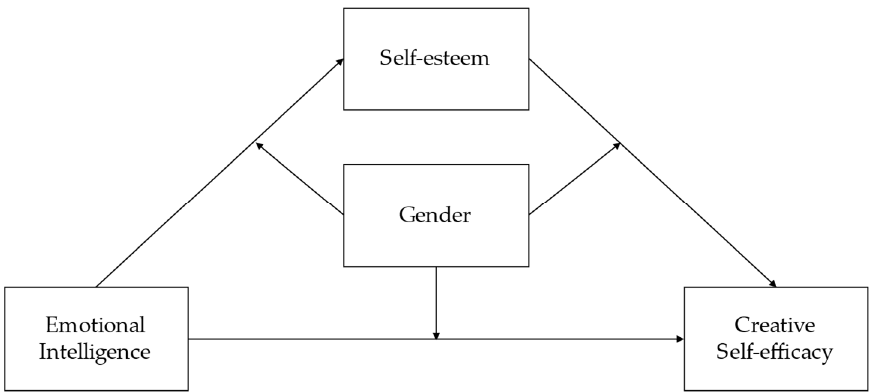
Figure 1. The hypothesized